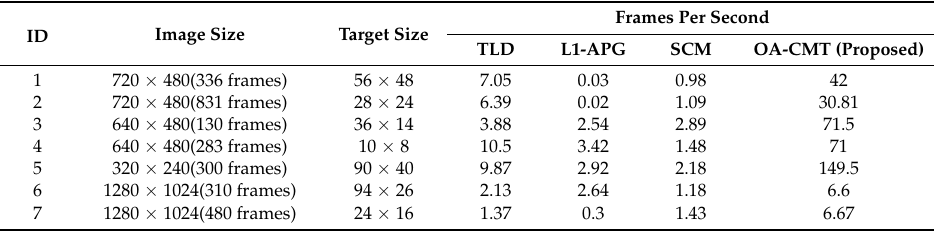
Table 2. Comparison of computational